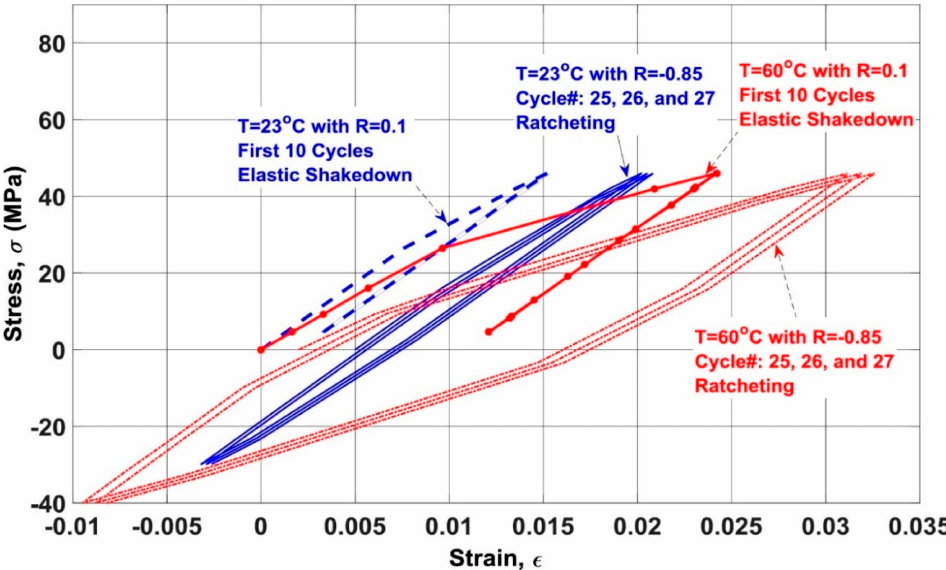
Figure 3. Hysteresis thermal energy loops for highly crystalline thermoplastic DuPont TM Delrin ® 100 polymer under fatigue loading at two different temperatures, 23 ◦ C and 60 ◦ C, adapted with permission from Ref. [8]. Copyright © 2017 Elsevier